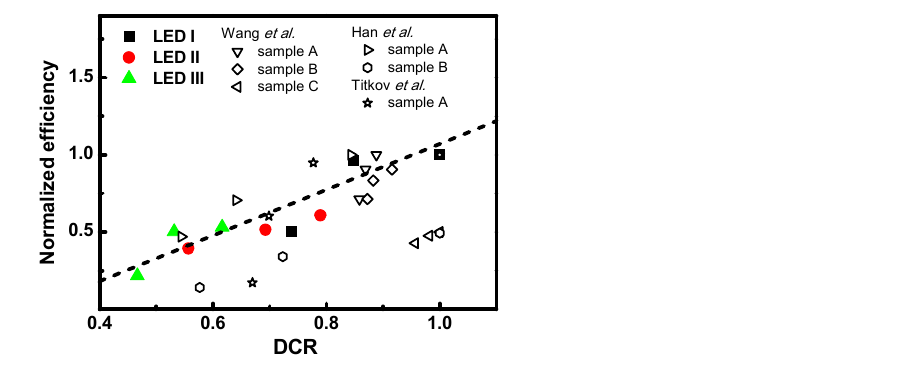
Figure 9. Normalized efficiency as a function of DCR for devices LED I, LED II, and LED III with different injection currents. Table 2. Data published in previous reports of thermally introduced resistance with increasing injection current levels. The estimated trend for the Debye temperature and electron-coupling is approximately congruent with our results of LED samples.